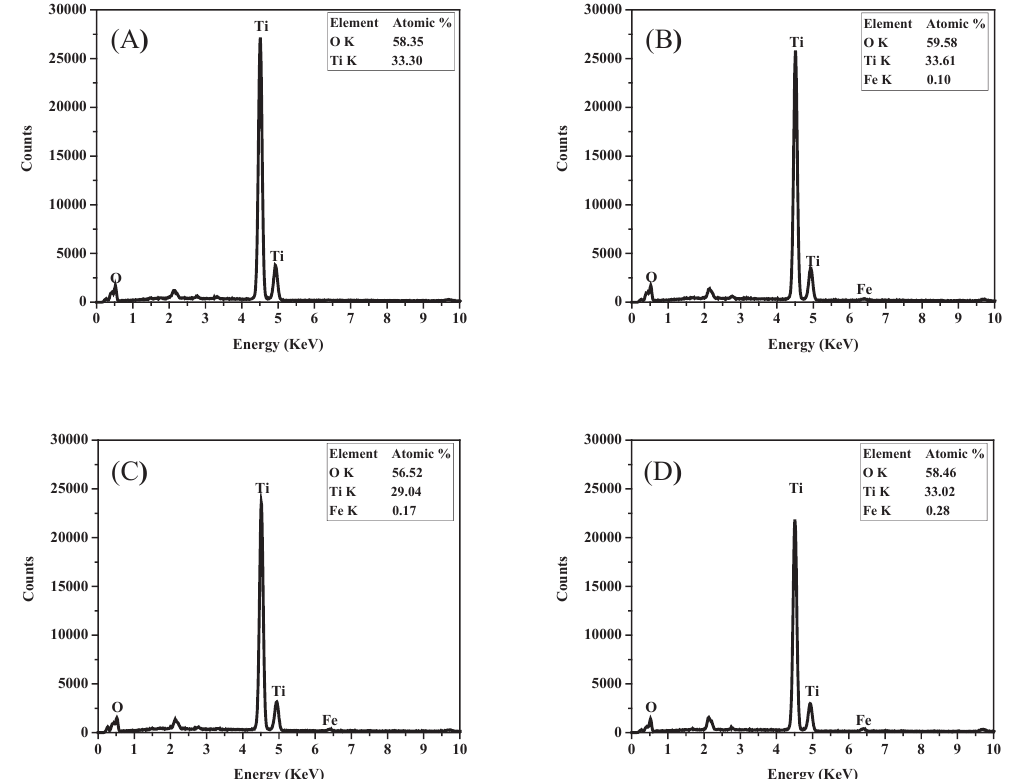
Figure 4: EDS patterns of (A) undoped TiO 2 , (B) 0.25% Fe-doped TiO 2 , (C) 0.5% Fe-doped TiO 2 and (D) 0.75% Fe-doped TiO 2